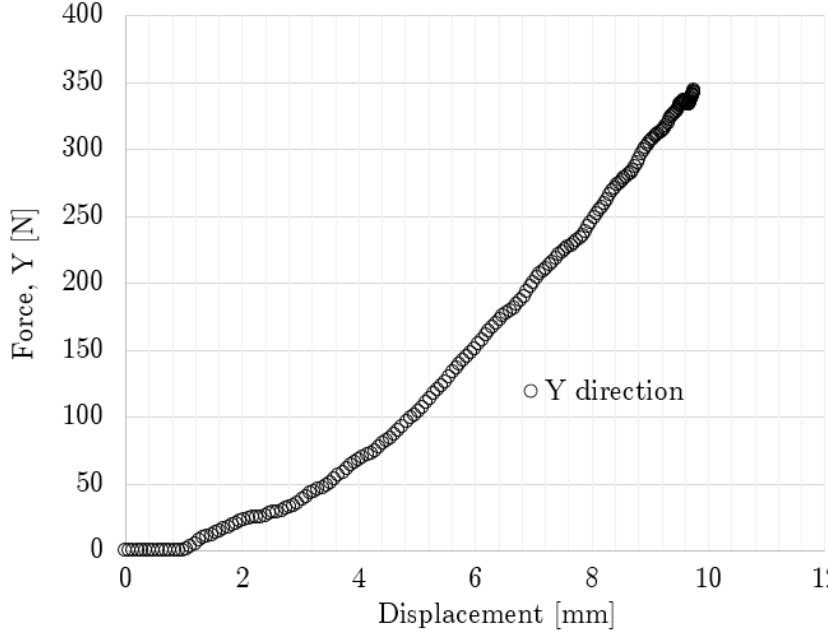
Figure 11. Impact force–displacement curve for oblique none ‐ graded lattice.